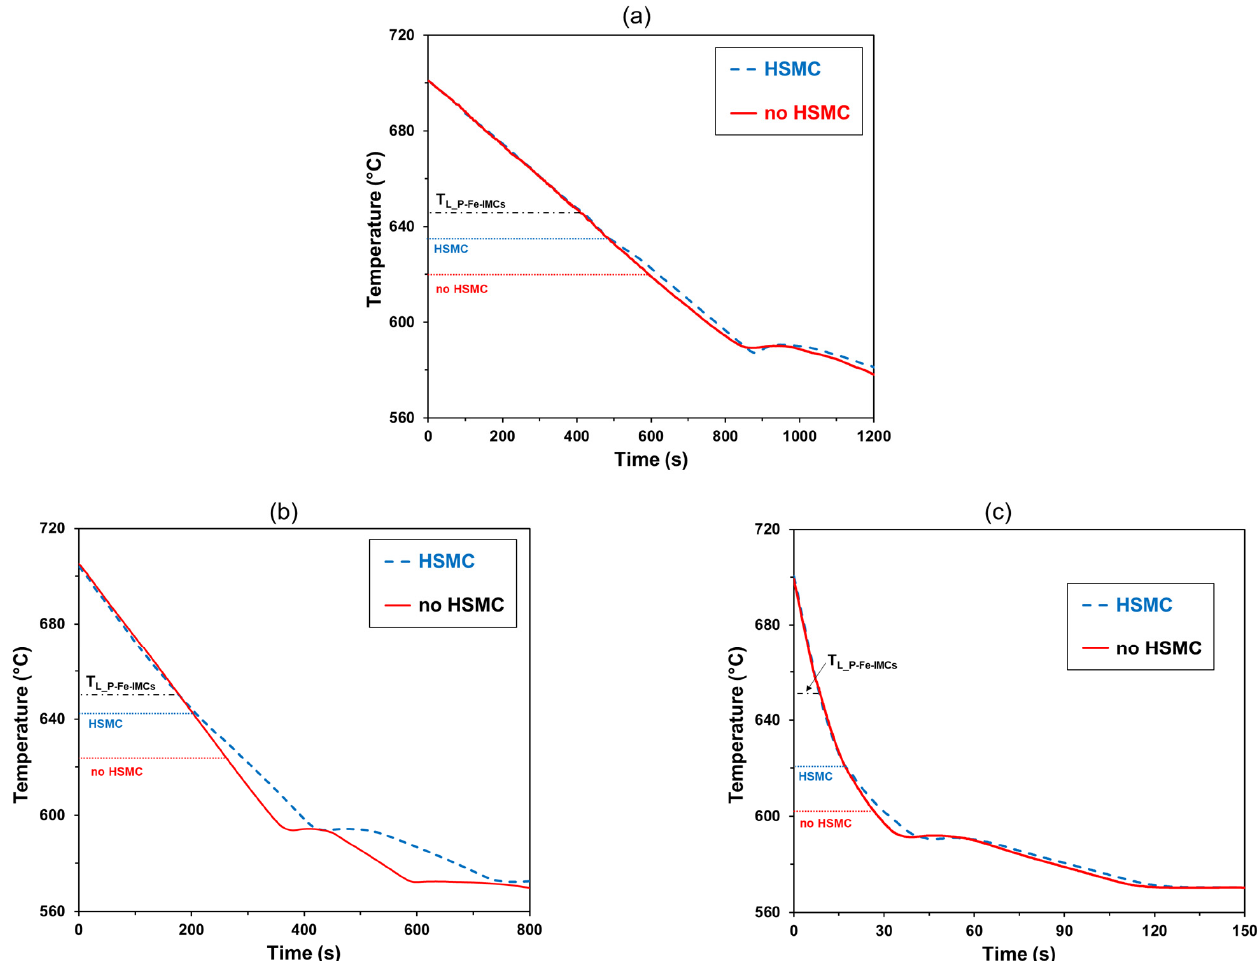
Figure 5. Cooling curves of A380 aluminium melts before and after HSMC at 700 °C for 10 min. ( a ) Alloy 1 at − 0.15 K/s; ( b ) Alloy 2 at − 0.3 K/s; ( c ) Alloy 2 at − 3.2 K/s.